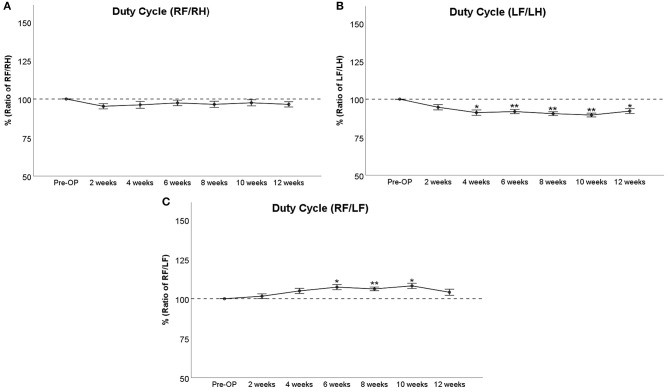
Assessment of Duty Cycle following median nerve resection and autograft repair. The panels depict the comparison of right front paw (RF) to right hind paw (RH) (A), left front paw (LF) to left hind paw (LH) (B), or RF to LF (C), *p < 0.05 as compared to Pre-OP, **p < 0.01 as compared to Pre-OP.